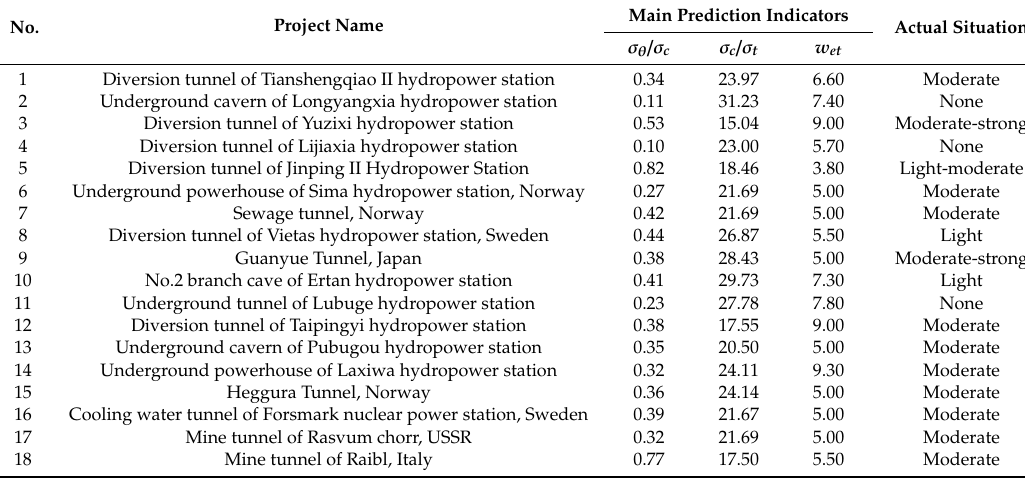
Table 3. Basic data of 18 typical rockburst cases around the